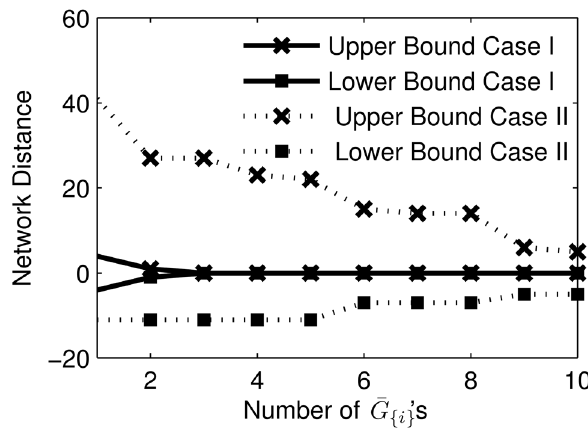
Figure 5. Examples of the ensemble inference of random networks with 10 genes. In case I, the GRN has 8 edges and is inferable from the accessibility matrices (cid:2) GG 6 0 and as few as three (cid:2) GG f i g ’s. In case II, the GRN has 13 edges and is not inferable.